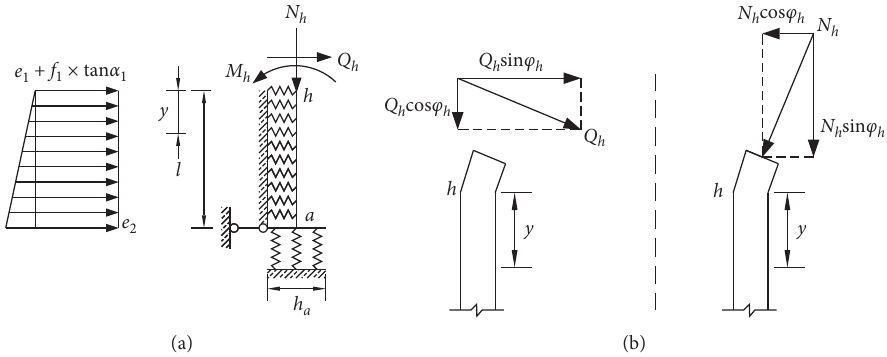
Figure 5: The internal forces on the left side wall: (a) forces transferred to the top of the side wall; (b) the decomposition of the internal forces at the top of the side wall.